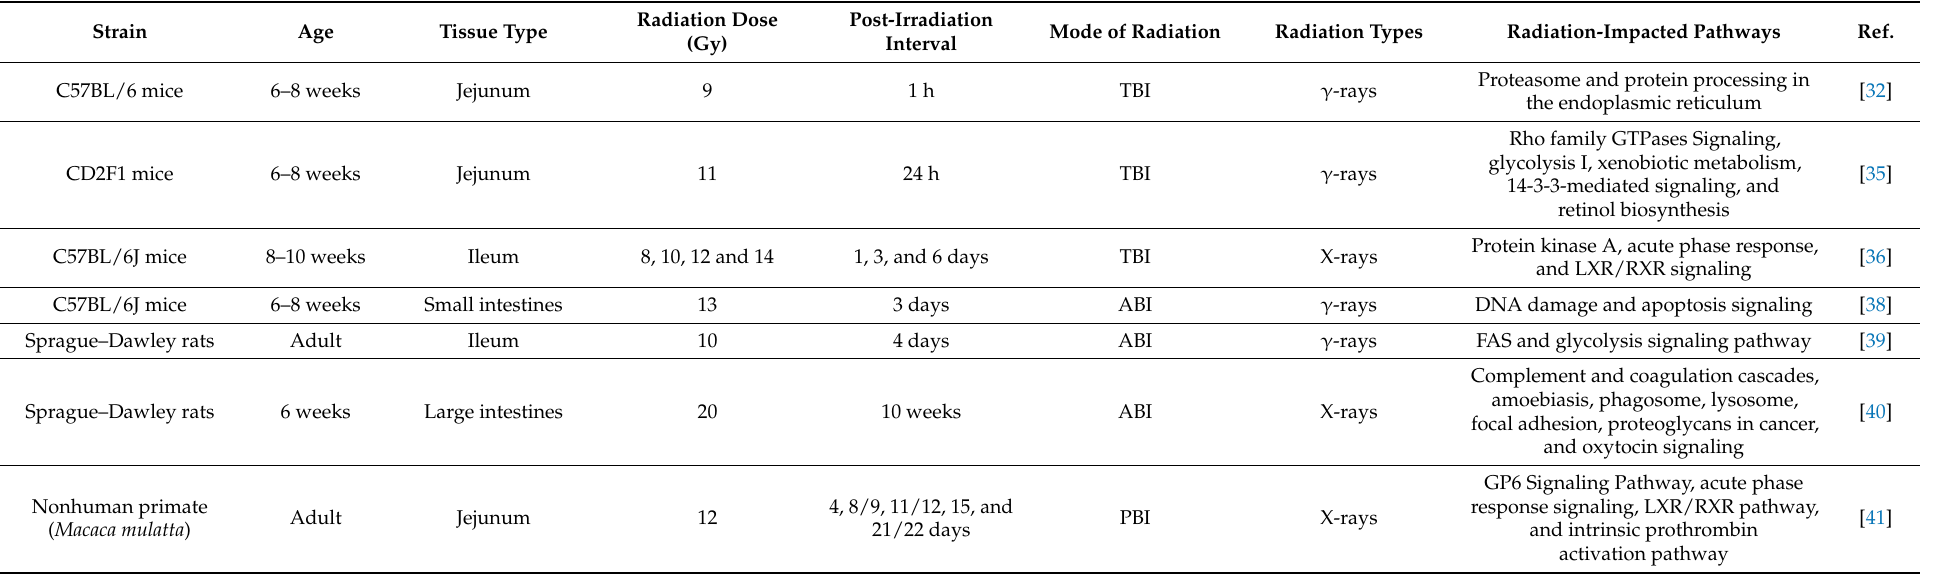
Table 2. Pathways dysregulated by radiation exposure in normal intestinal